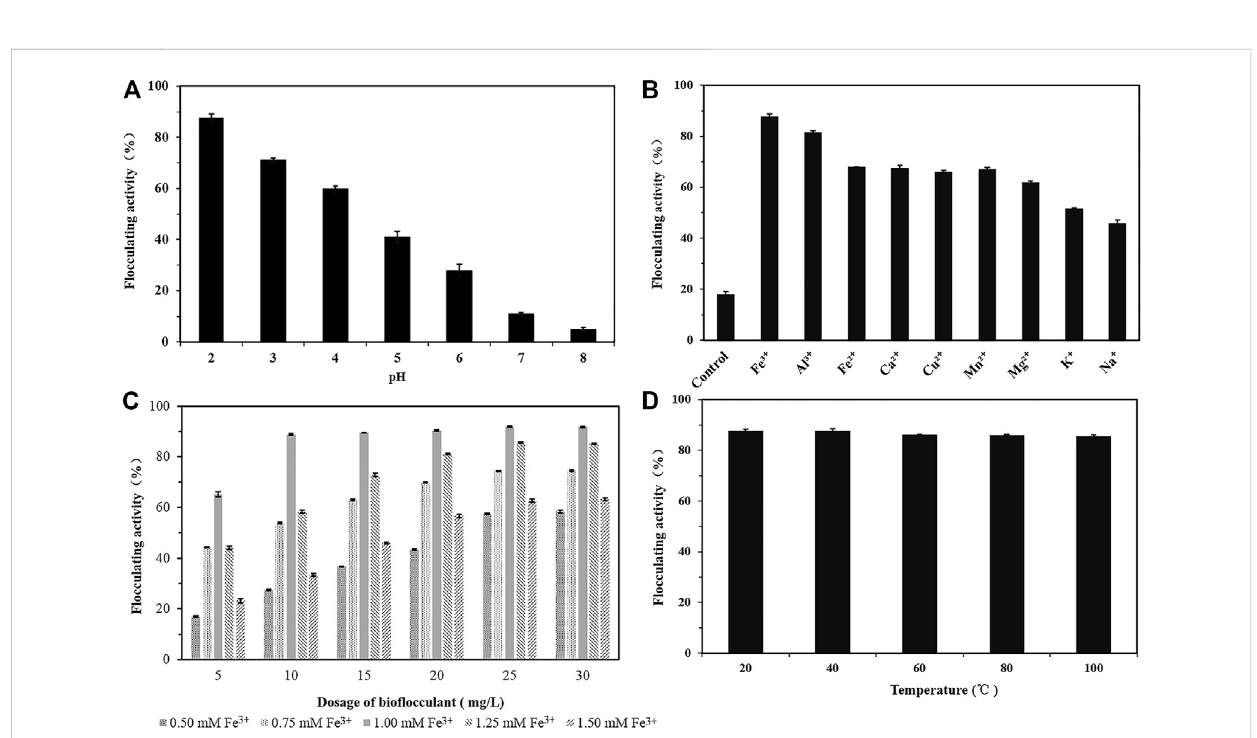
FIGURE 4 The effects of pH (A) , cations (B) , dosage of the bio fl occulant and Fe 3+ (C) , temperature (D) on the fl occulating activity of Kaolin suspension by the bio fl occulant.